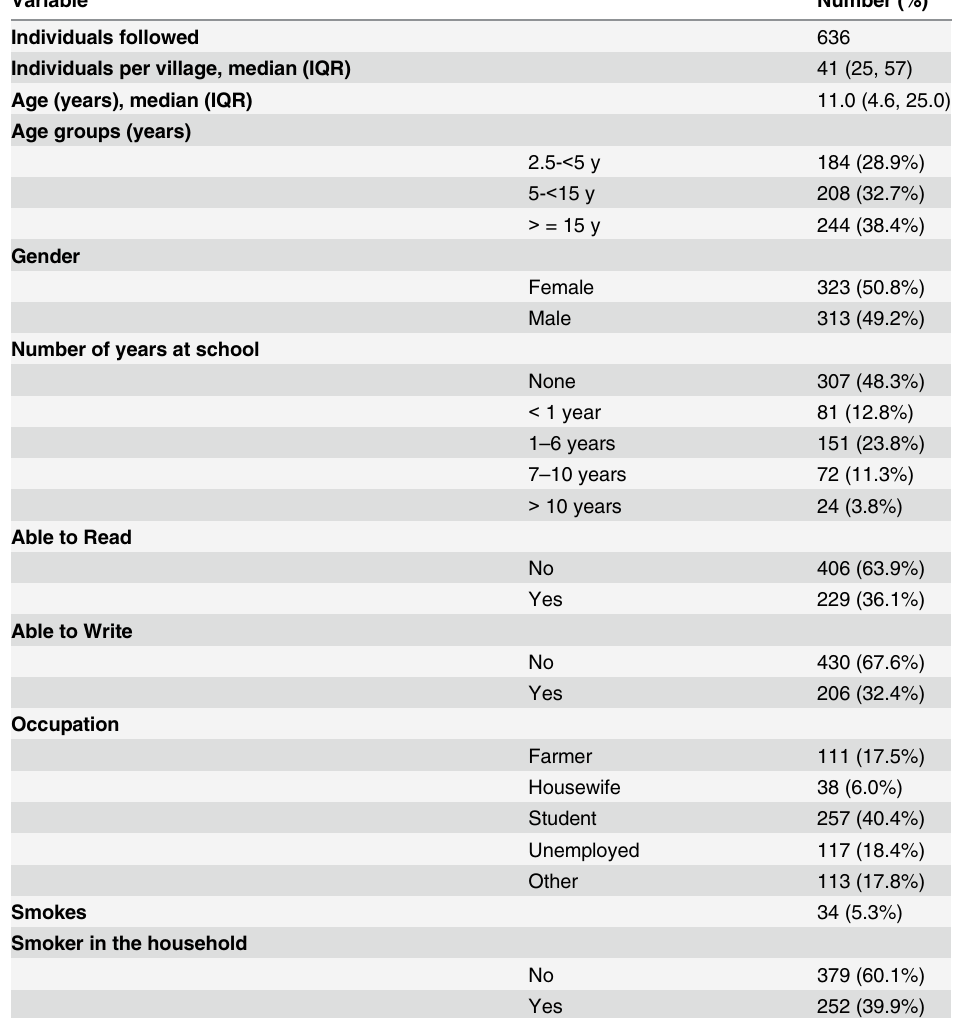
Table 1. Characteristics of the individuals participating in the longitudinal